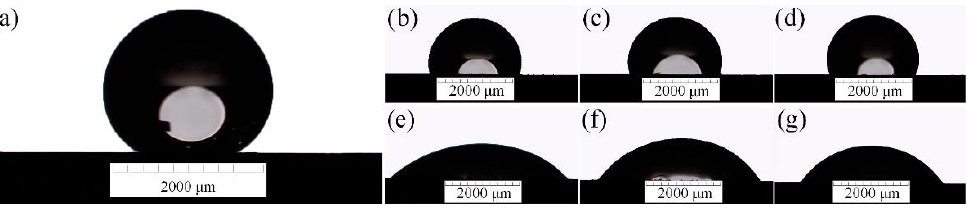
Figure 7. The drop shapes for Hanks’ solution at 37 ◦ C on the sample surface: ( a ) S0; ( b ) S1; ( c ) S2; ( d ) S3; ( e ) S1 HTT; ( f ) S2 HTT; ( g ) S3 HTT. The measured wetting angles are shown in Table 5. Table 5. Measured contact angles.